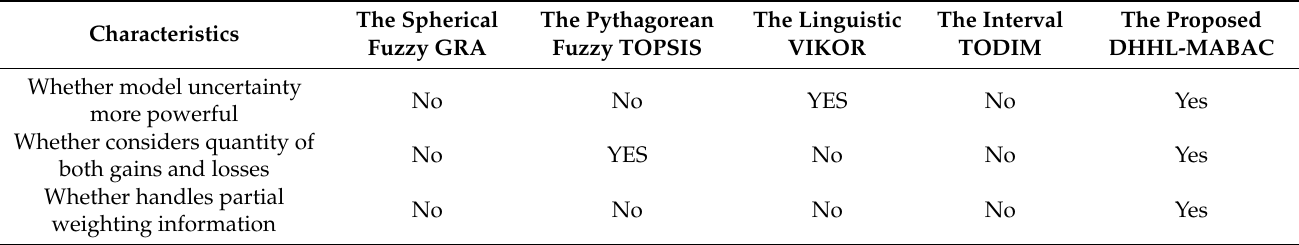
Table 6. Characteristics of the considered EDM